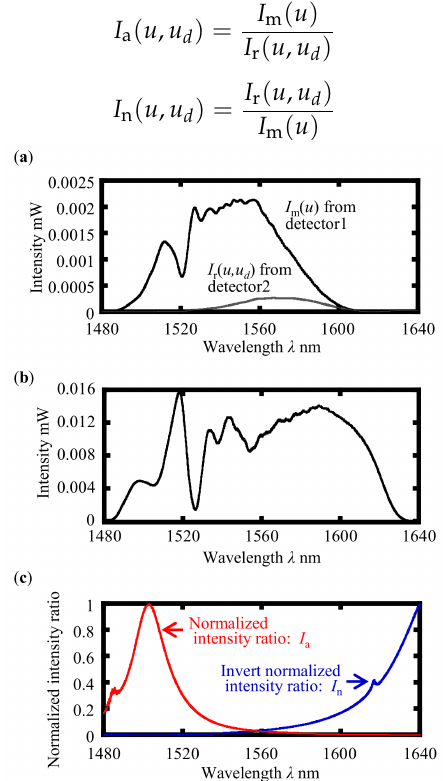
Figure 2. Typical normalized intensity ratio obtained by the dual-detector chromatic confocal configuration with a mode-locked femtosecond laser source. ( a ) Light intensities obtained by the two identical fiber detectors with a target position of 40 µ m and a defocus d of 150 µ m; ( b ) Working spectrum of the mode-locked femtosecond laser source; ( c ) Normalized intensity ratio and invert normalized intensity ratio obtained from the two light